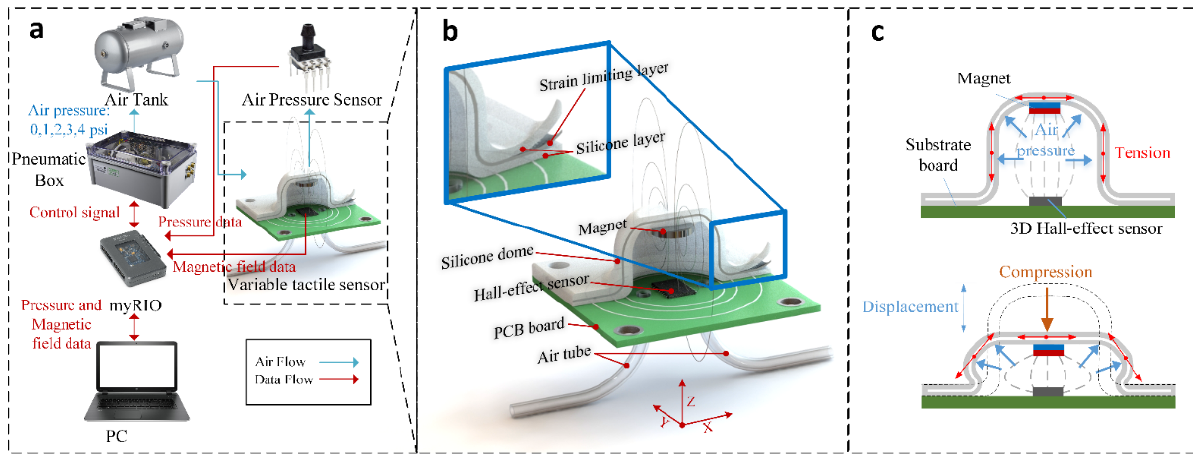
Figure 1. Overview of the soft sensor with an adjustable compliance: ( a ) A closed-loop control system, which is connected to a pneumatic circuit with feedback control of air pressure for altering the air pressure inside an elastically inflatable dome with an embedded magnet mounted on top of a Hall-effect sensor. This system is connected to a real-time control system to record data from the Hall-effect and air pressure sensors. ( b ) The soft sensor consists of elastically inflatable fluidic dome, embedded magnet, and a Hall-effect sensor soldered on a PCB board. ( c ) The elastomeric fluidic dome is reinforced by a sheet of inextensible embroidery fabric to control the expansion of the structure under variable air pressure conditions. With known overall stiffness of the structure, the sensing system can be calibrated to measure input force from the displacement of the magnet detected by the Hall-effect sensor during mechanical compression.